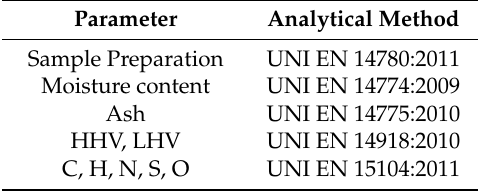
Table 3. Standard methods of physical and chemical